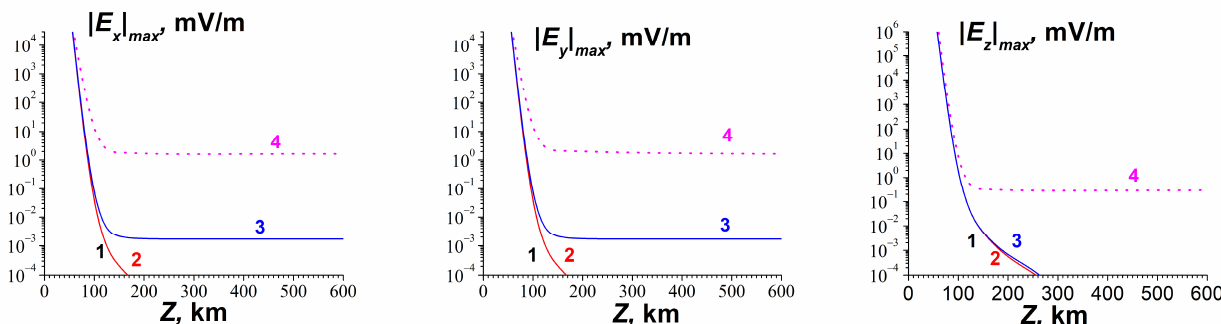
Figure 7. The dependencies of the maximum values of the electric field components on the vertical coordinate obtained in the quasi-electrostatic simulations, the same frequency ω = 0.025 s − 1 . The geomagnetic field inclination is θ i = 10°. The case of open geomagnetic field lines is considered. Curves 1 are for L z = 1000 km, 2 are for L z = 1500 km, 3 are for L z = 25 , 000 km. For a comparison, the results of the dynamic simulations are given in curves 4 taken from Figure 5, for L z = 1500 km. Leaving empty space in the lower atmosphere area as in Figure 5a–c and in Figures 7, 8 and 13, corresponds to the rejection of claims for an adequate definition of the electric field in the external current region, introduced instead of an synergetic self-consistent definition of current and field, as explained in detail in the introduction to this work, as well as in [15].